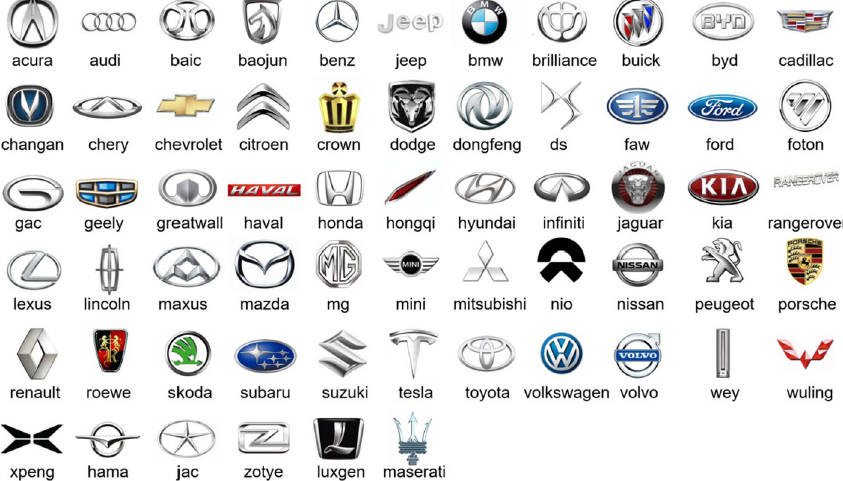
Fig. 2 Sixty-one classes of vehicle